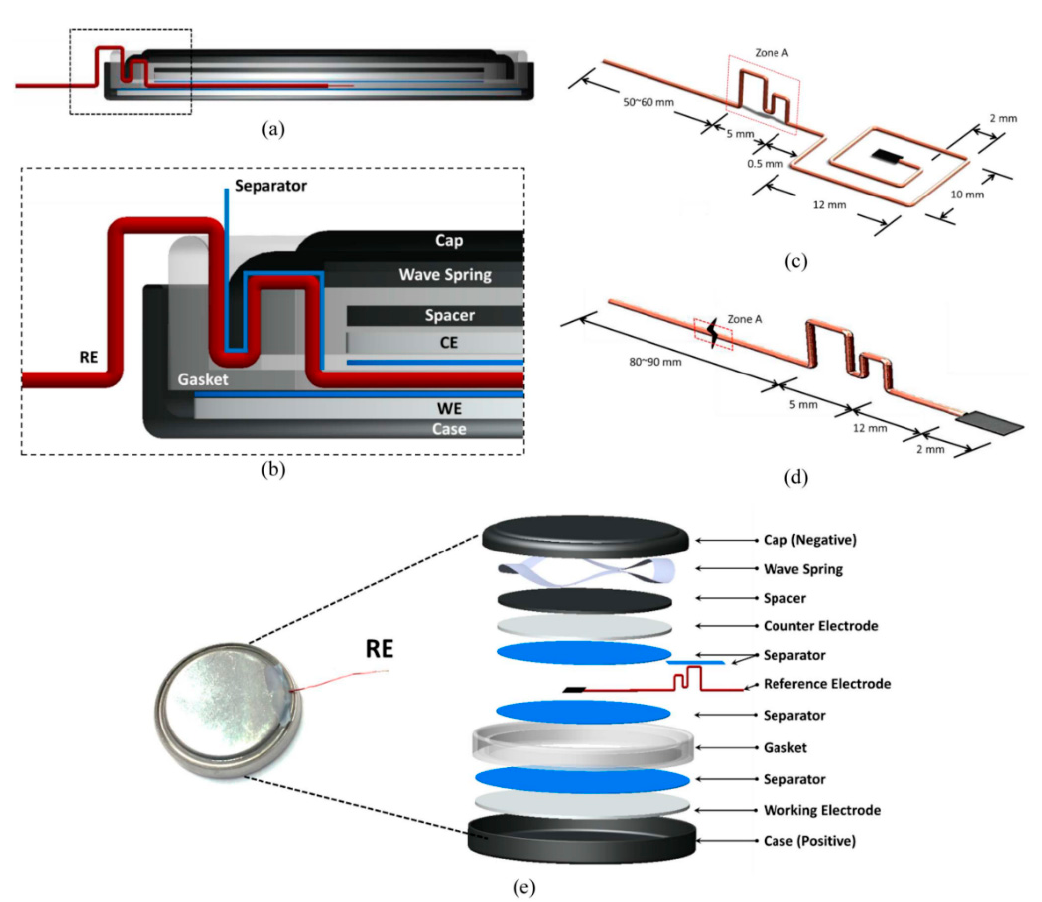
Figure 17. Coin cell equipped with a third RE ( a ). Enlargement of the coin cell area containing the RE wire connection ( b ). Two different shapes of RE used in coin cell configurations ( c , d ). Position of the RE inside the three-electrode coin cell ( e ). Reproduced with permission from [37].